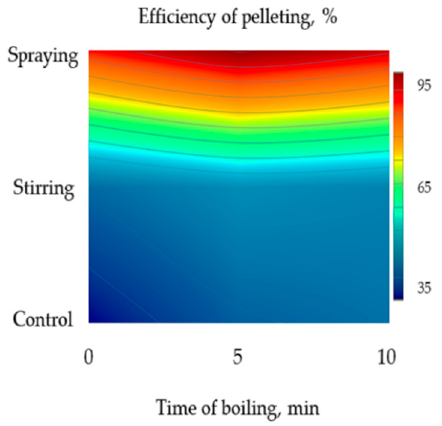
Figure 8. Two-dimensional fuzzy contour plotting for the interactive e ff ect of time of boiling and method of addition on the e ffi ciency of the process of pelleting in forming non-wood pellets from residual biomass from distillation of cellulosic bioethanol with liquid-state food waste.